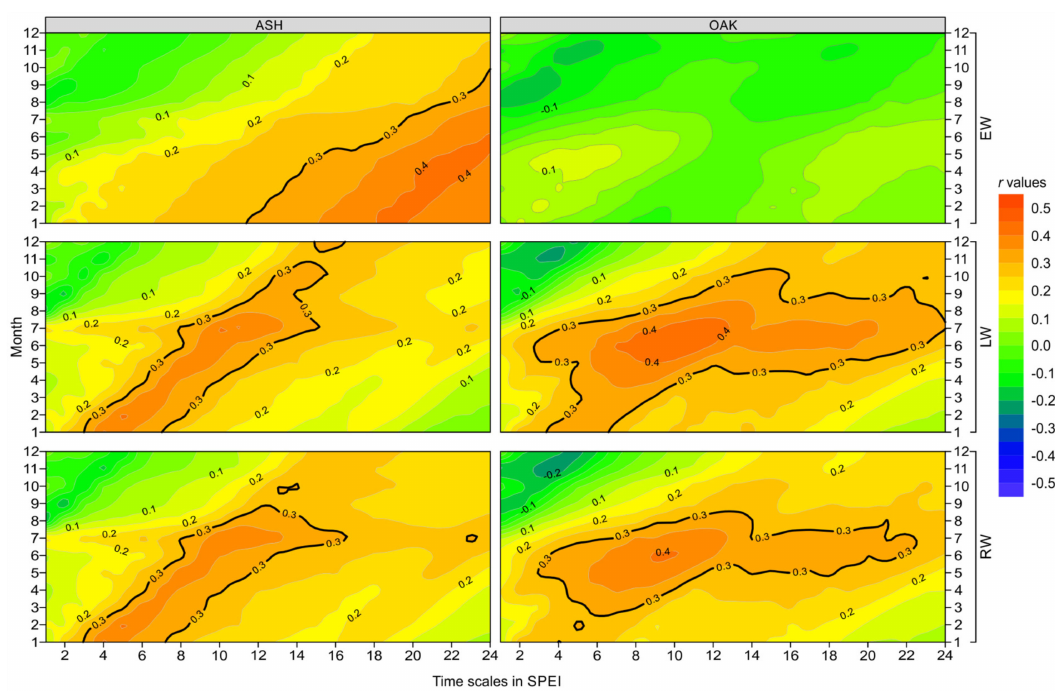
Figure 5. Correlation between growth indices and monthly Standardized